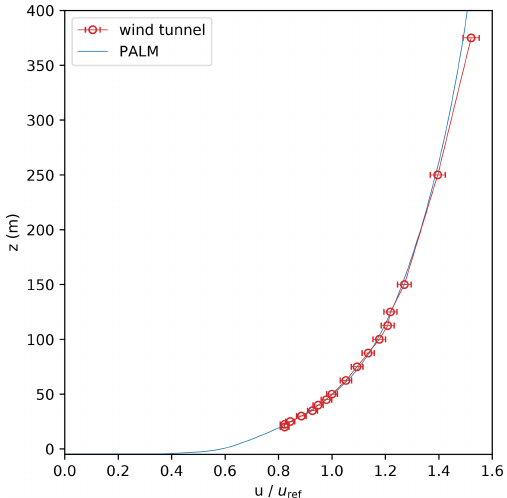
Figure 2. Mean profiles of the approaching flow for the wind-tunnel experiment and the PALM simulation normalized with the reference velocity u ref = u(z = 50m ) . Note that z = 0m is defined at street- level height while the lowest level within both experiments was at z = − 5m, which is the water-level